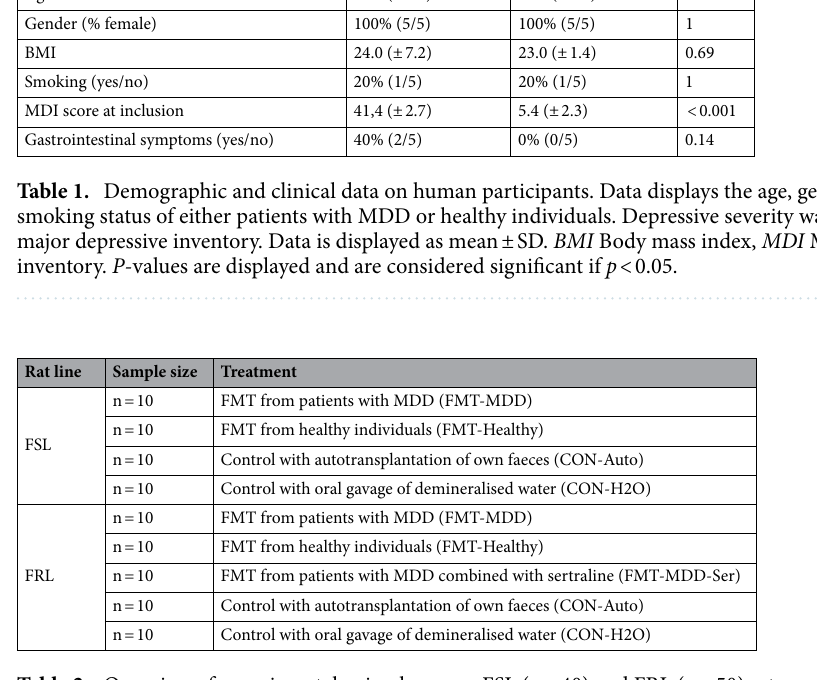
Table 2. Overview of experimental animal groups. FSL (n = 40) and FRL (n = 50) rats were used. Animal groups (n = 10 per group) received either faecal microbiota transplantations (FMT) from patients with MDD (FMT-MDD), FMT from healthy individuals (FMT-Healthy), FMT with their own faeces (CON-Auto) or water by oral gavage (CON-H2O). Additionally, one group of FRL rats received FMT from patients with MDD combined with simultaneous treatment with sertraline